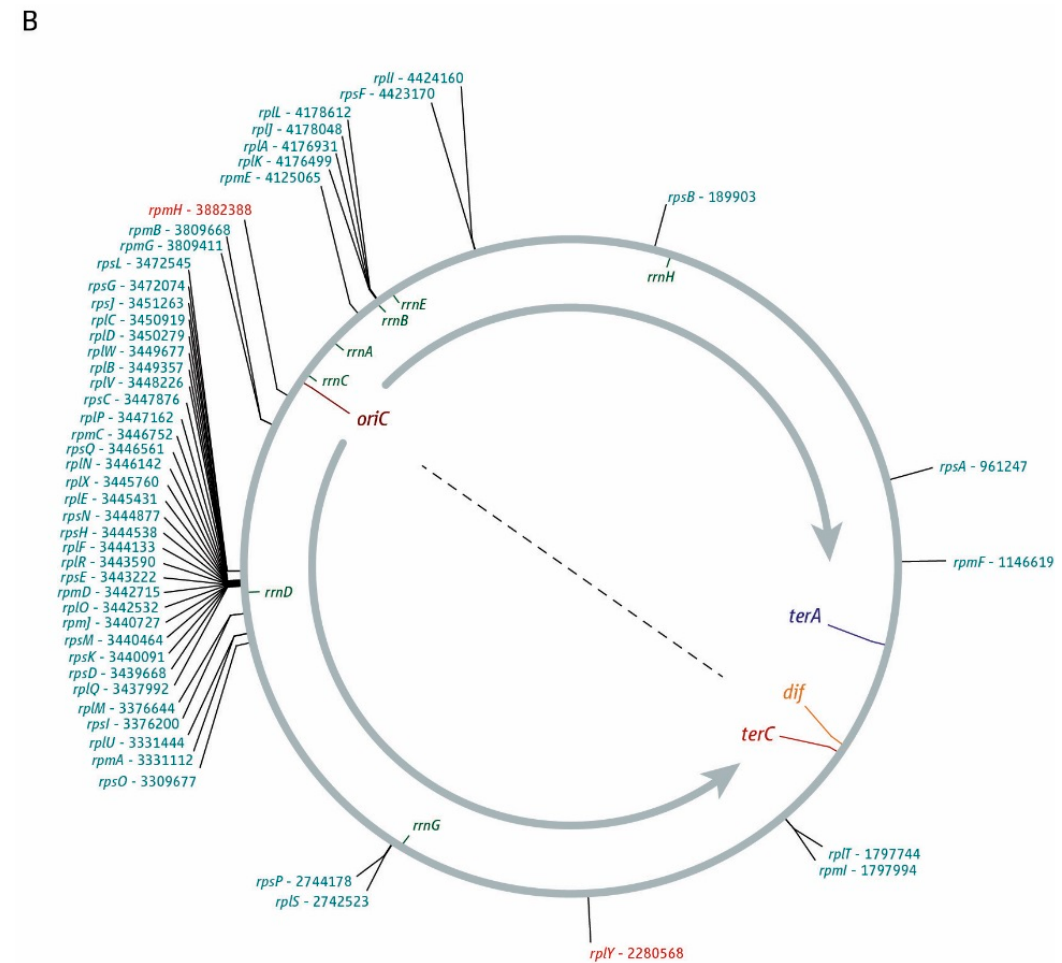
Figure 3. Replication and transcription parameters of E. coli cells with one and two replication origins. ( A ) Replichore lengths in E. coli cells with two replication origins in the presence and absence of a functional replication fork trap. A schematic of the E. coli chromosome is shown at the bottom, highlighting the location and coordinates of oriC , oriZ , the chromosome dimer resolution site dif , ter sites A–J , and rrn operons A–E , G , and H . The relevant genotypes are stated on the left, with coloured bars representing the length of the replichore from each of the origins present, as calculated by the LOESS minima. Arithmetic mid ‐ points between origin(s) are highlighted by grey lines. Data were re ‐ plotted from [10]; ( B ) Location and orientation of rrn operons as well as genes coding for ribosomal proteins within the E. coli chromosome. oriC , the innermost ter sites and the dif chromosome resolution site are indicated. Orientation of replication within a replichore is indicated by a grey arrow. Locations of rrn operons A–E , G , and H are shown on the inside. All rrn operons are transcribed co ‐ directionally with DNA replication (green). Locations of genes encoding ribosomal proteins are indicated on the outside. Genes transcribed co ‐ directionally with replication are shown in cyan, genes transcribed in head ‐ on orientation relative to replication in the replichore are shown in red.